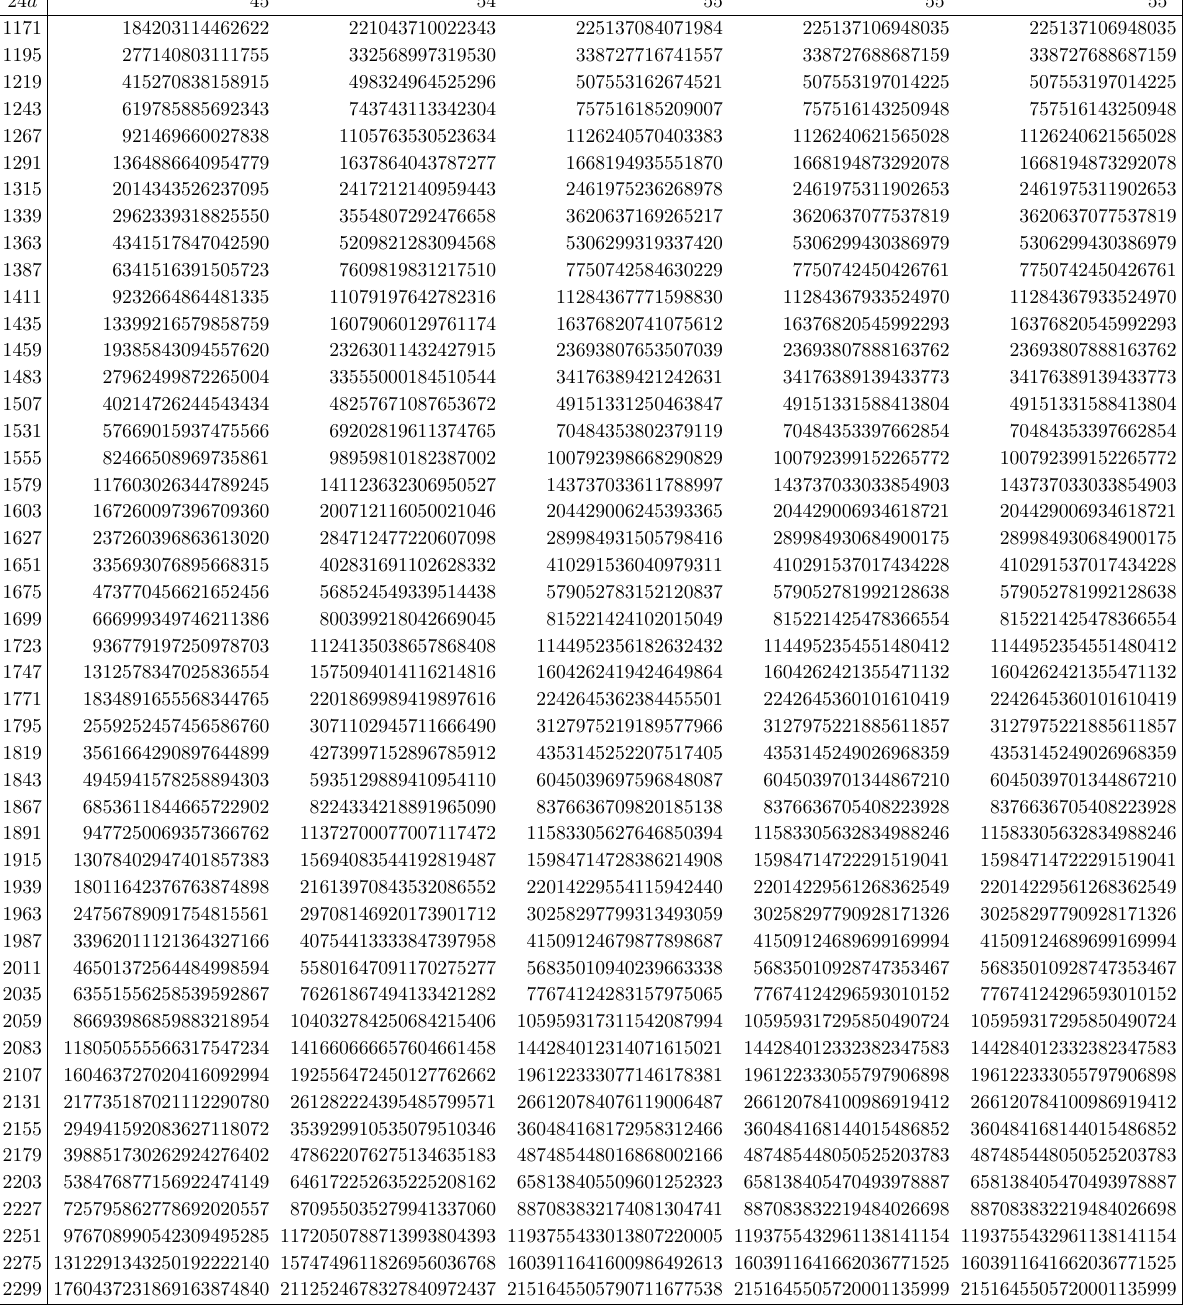
Table 7 . Multiplicity generating functions f (1)